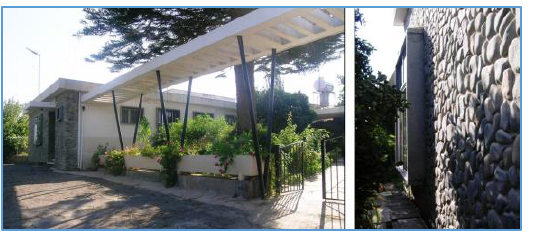
Figure 21. Using Iron forks in the right and exposed stone facade in the left (Hera,